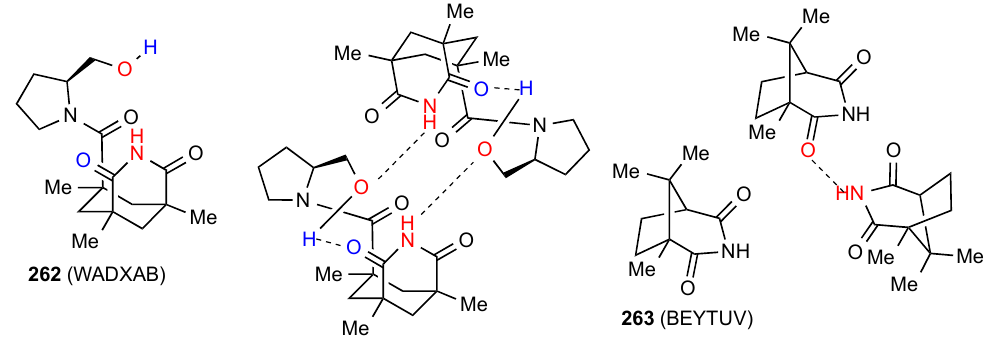
Figure 74. Structure adopted by compound 262.